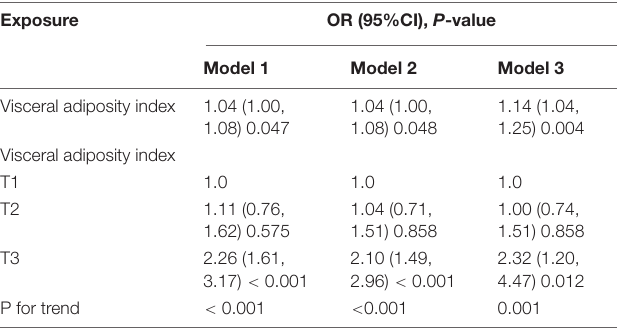
TABLE 3 | Relationship between visceral adiposity index and depressive symptoms in different models. Exposure